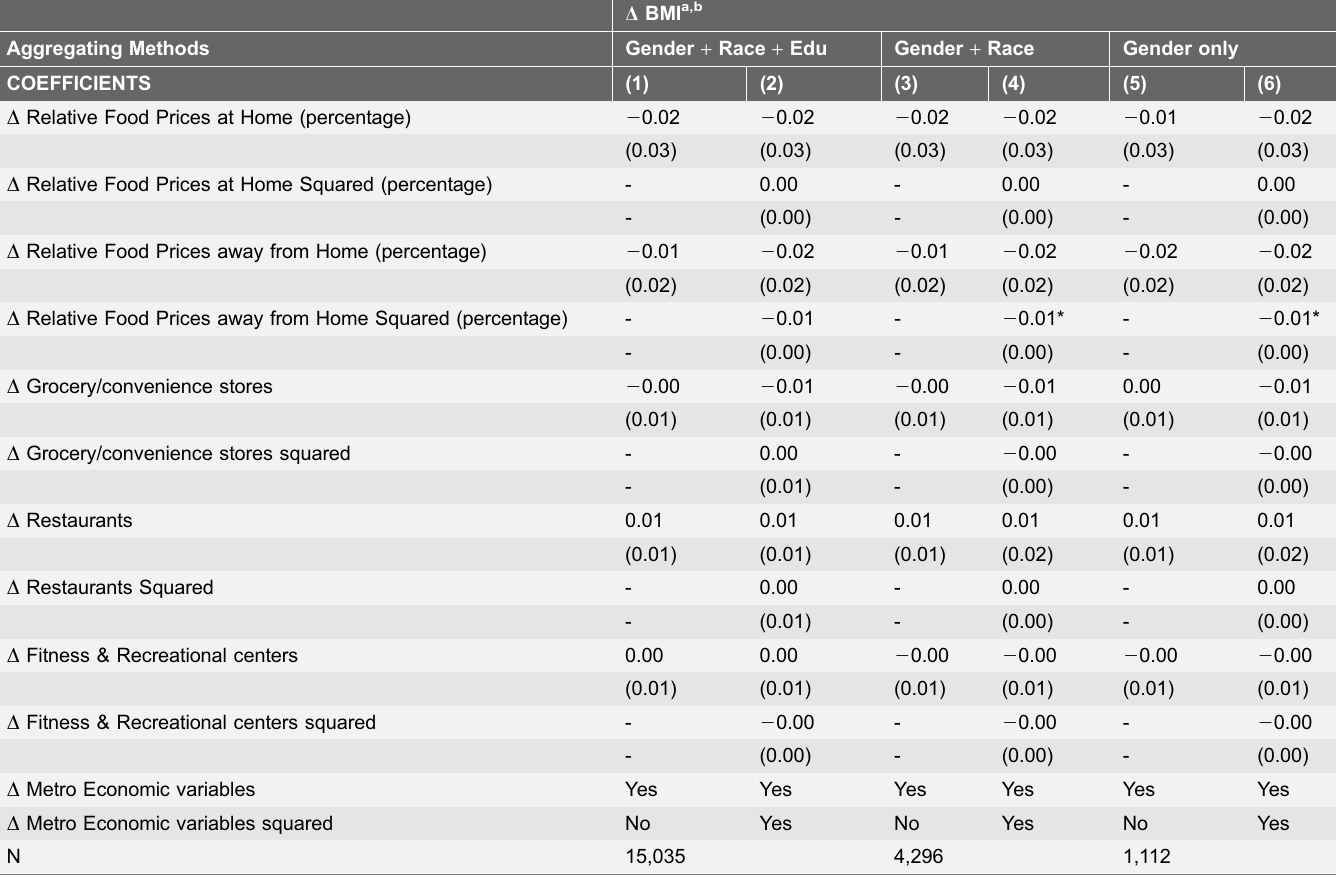
Table 7. The Estimated Effects of Relative Food Price Changes on Changes in Body Mass Index: By Grouping